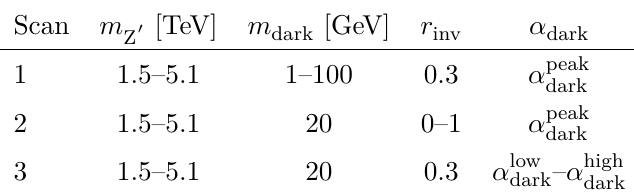
Table 1 . The three two-dimensional signal model parameter scans. For each scan, the ranges of the parameters that are varied in that scan are indicated by